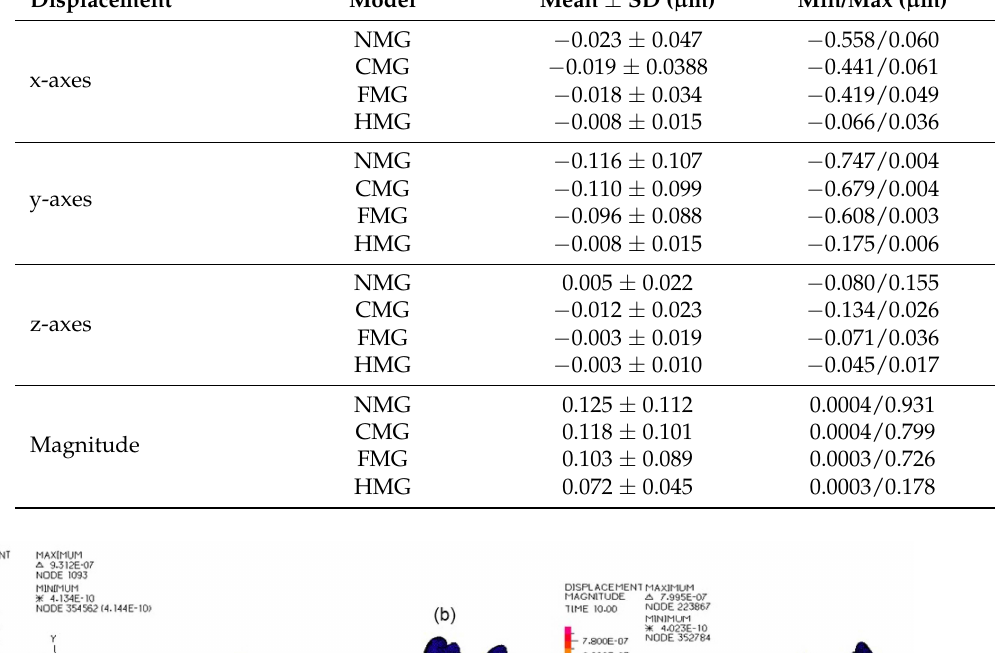
Table 5. Mean and range of displacements of the teeth in the different models.